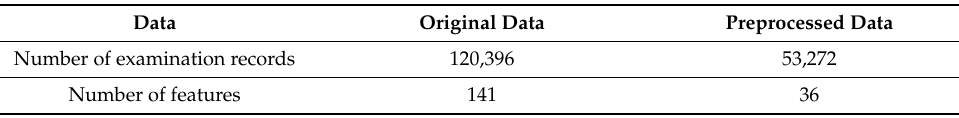
Table 5. Changes before and after data